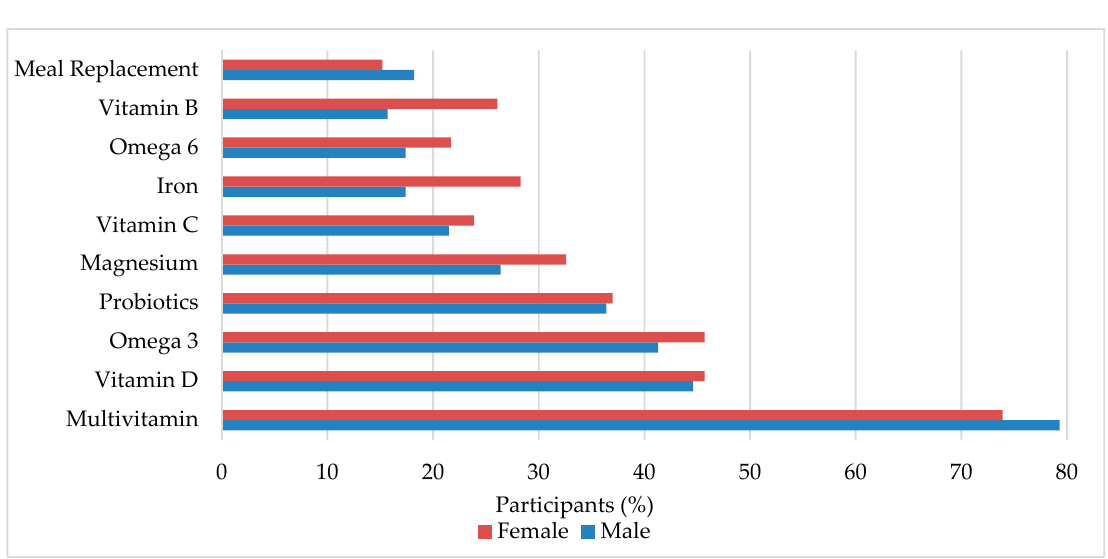
Figure 1. Dietary supplements commonly used in pediatric autism spectrum disorder (ASD). Male and female is percent within sex.